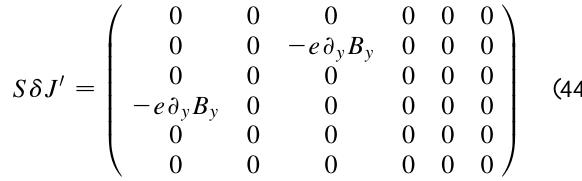
FIG. 5. (Color) B y (cid:1) z 0 (cid:2) in the main field region of a 90 ± HDSM magnet calculated by particle tracking and by perturbation